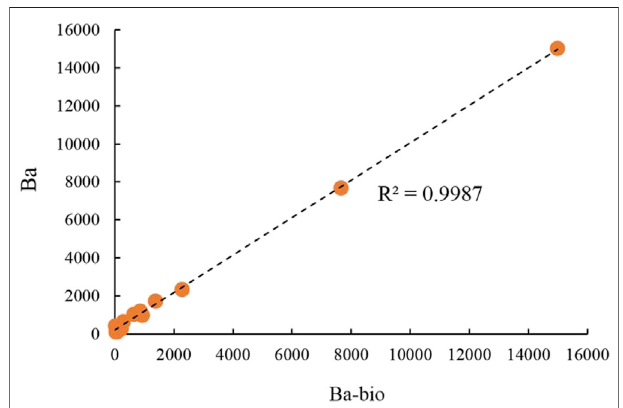
FIGURE 3 | Correlation between Ba-bio and Ba of the Yuertusi Formation samples in the Yutixi outcrop.